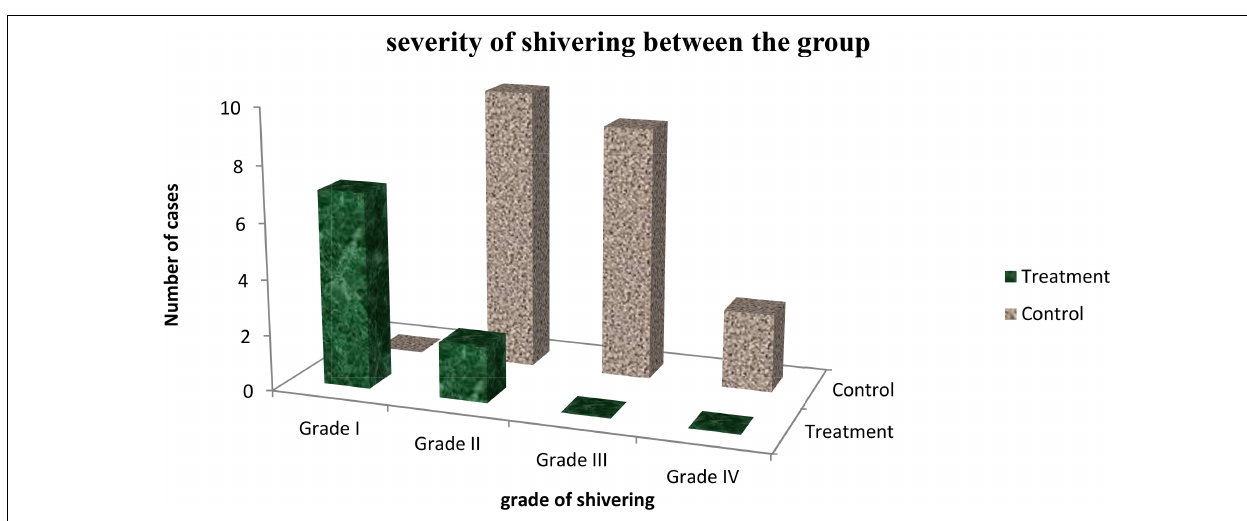
FIGURE 4 | Intensity of shivering between treatment and control group in Dilla University Referral Hospital, 2021/22.